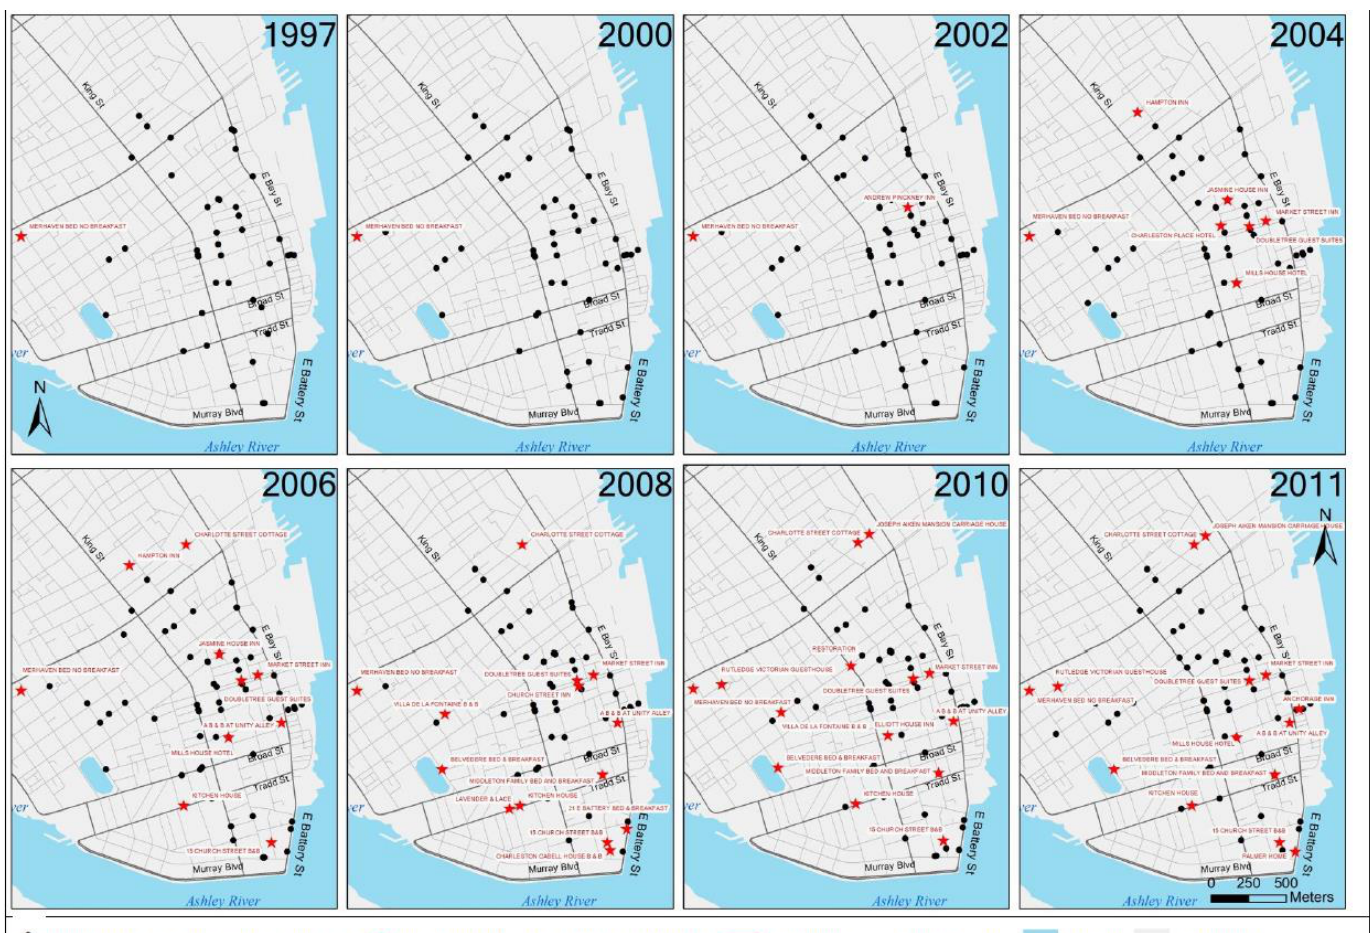
Figure 1. Original and updated hotels: Charleston, NC, USA.